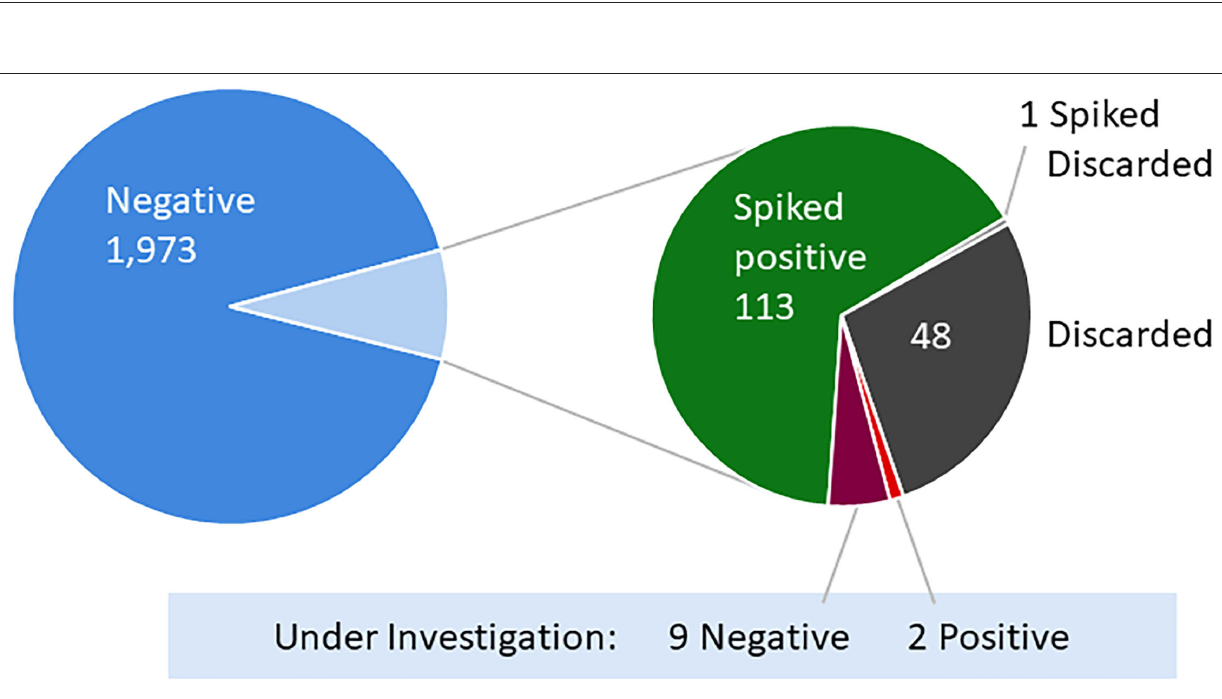
Frontiers in Public Health |